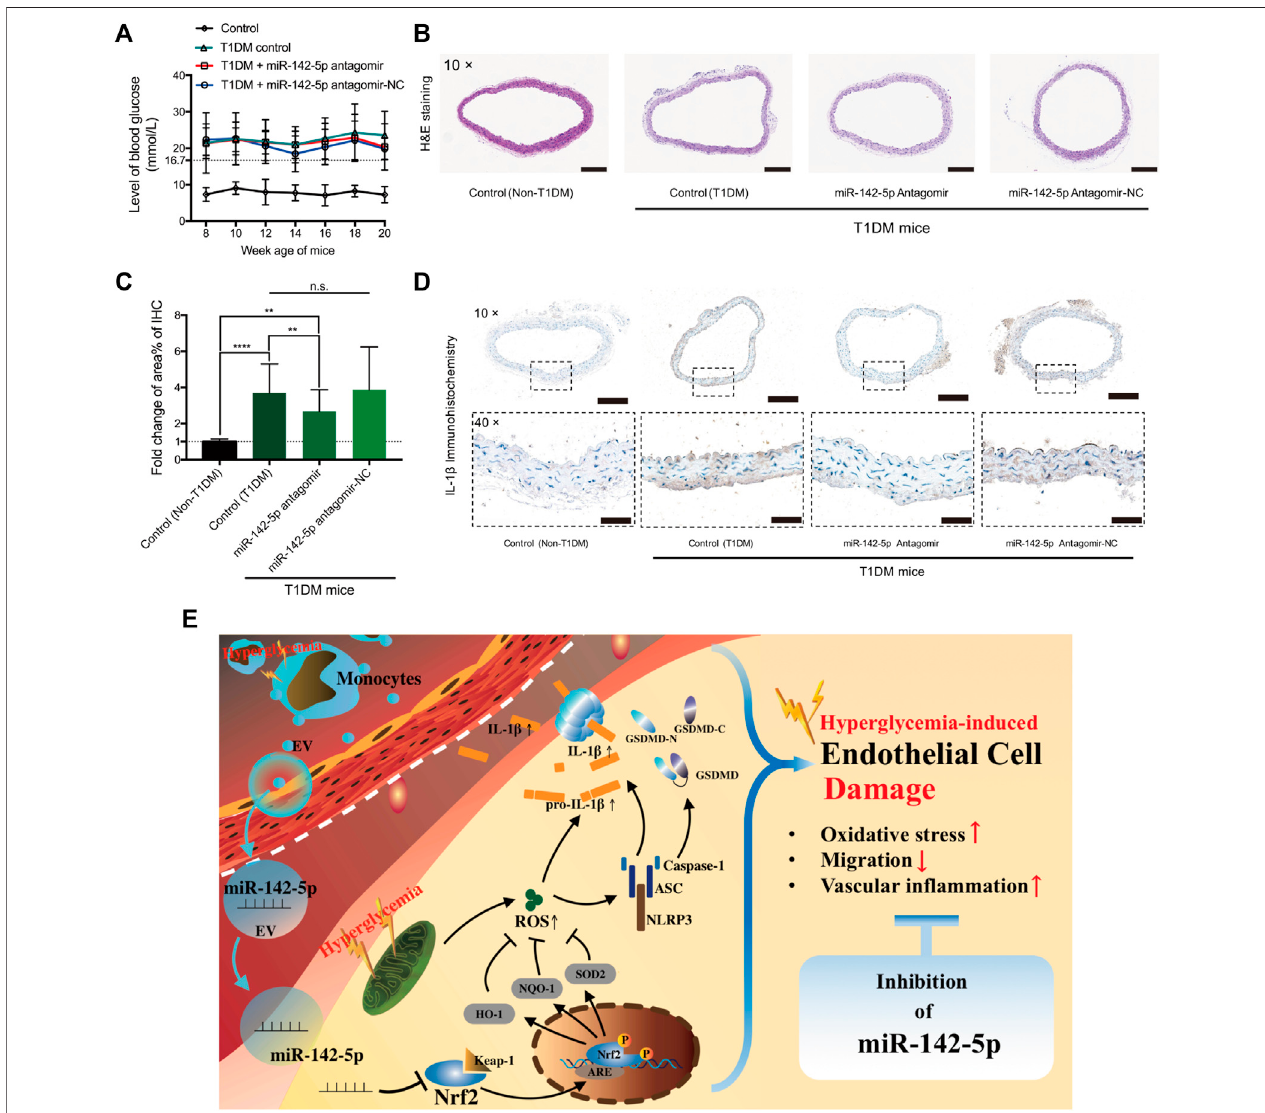
FIGURE 6| MiR-142-5p inhibition alleviates T1DM-induced vascular in fl ammation in the aorta (A) blood glucose level of mouse from four groups (B) Hematoxylin- eosin stainingofaortatissue harvestedfrom mousemodel at 20 weeks age (magni fi cation, ×10). Scalebar = 200 μ m (C,D) Relative foldchange inpositive